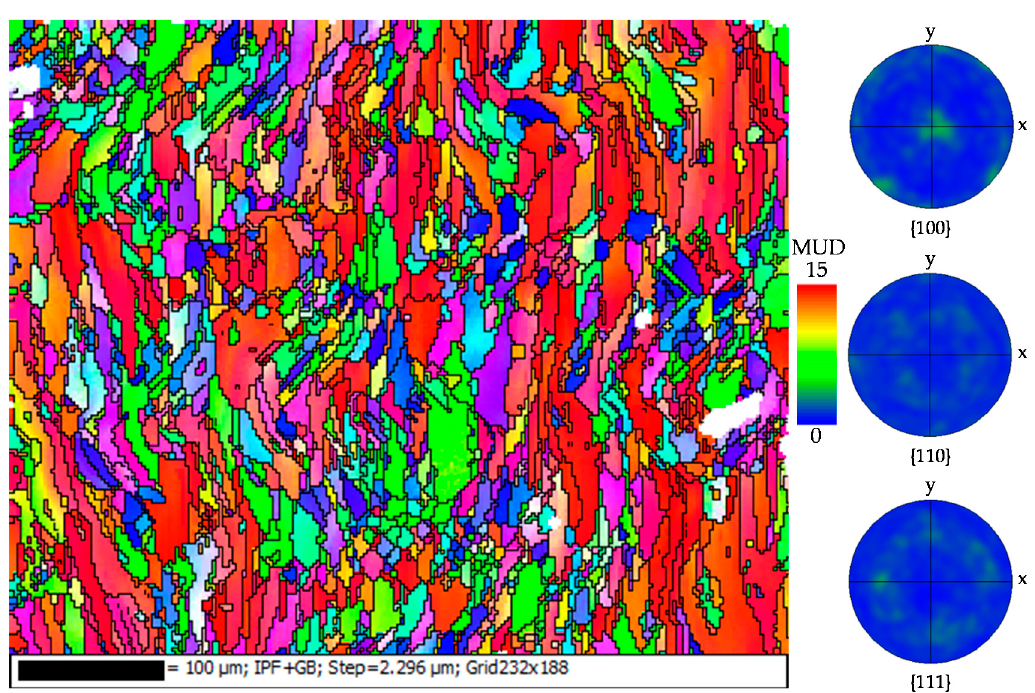
Figure A5. EBSD picture and pole figures for P L = 300 W, v s = 1240 mm/s, Δ y = 78 µm, T pre = 0 °C.